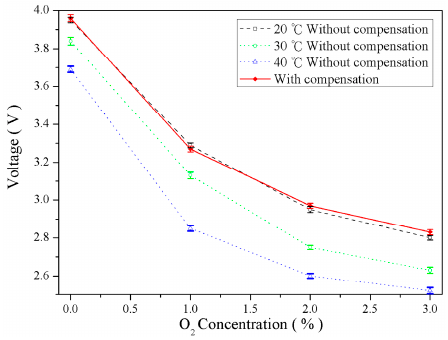
Figure 11. Comparison of O 2 concentration–voltage response relationships before and after temperature compensation.